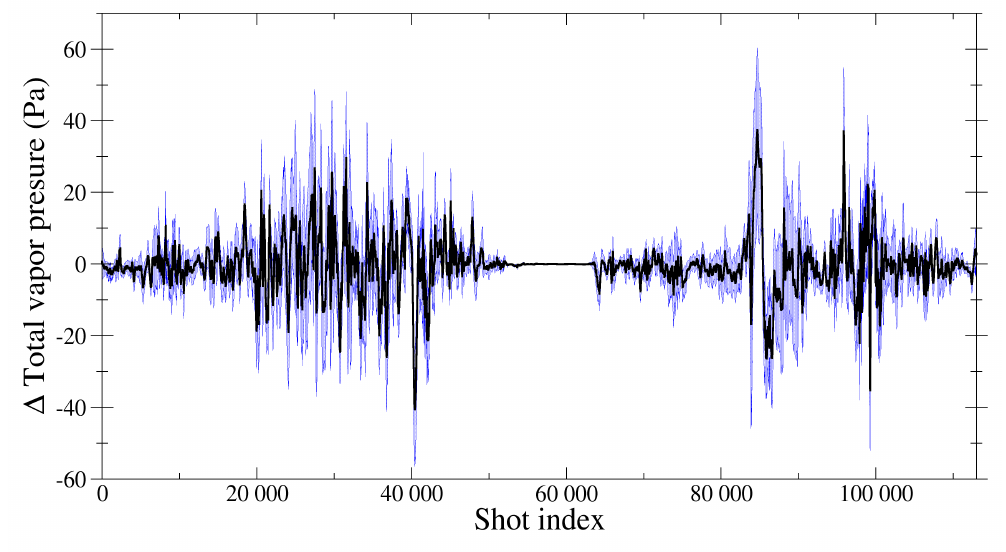
Figure 10. Discrepancies on the total amount of water vapour. Mean curve in black and area between ± one standard deviation in